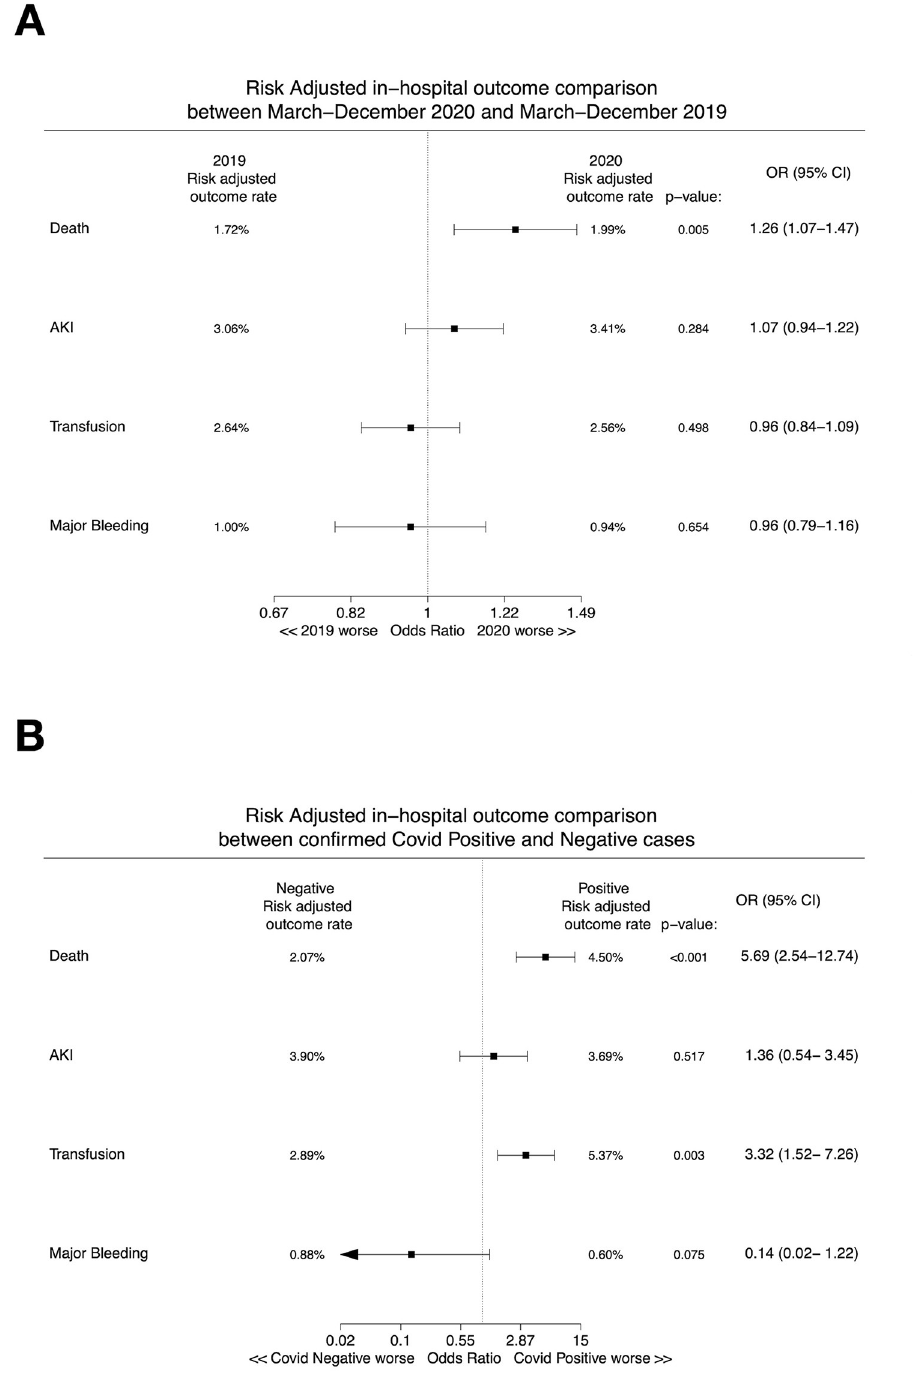
Fig 4. Risk-adjusted outcome comparison between (A) the pre-pandemic and pandemic period, and (B) within the pandemic cohort, between COVID-19 positive and negative patients. Abbreviations: AKI, acute kidney injury; CI, confidence interval; OR, odds